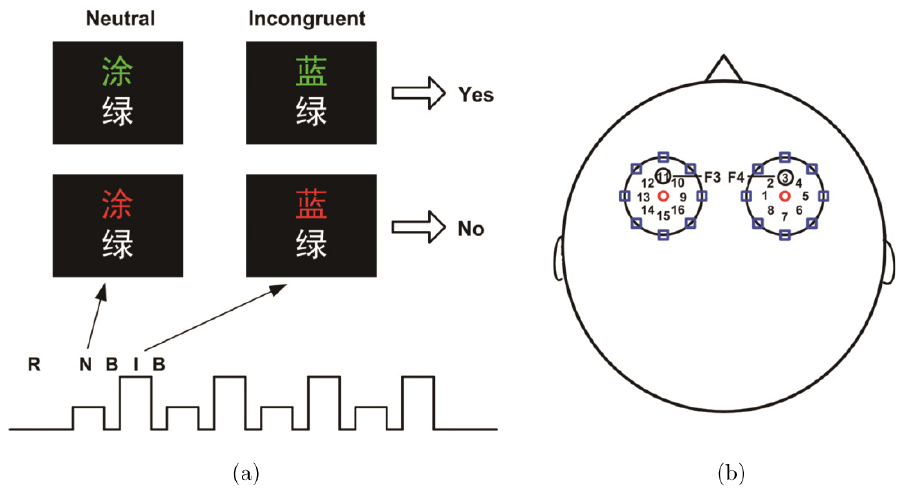
Fig. 1. (a) Examples of two stimulus conditions (top) and experimental design (bottom). , correspond to \blue", \green" and means \print". The bottom subgraph shows the blocks sequence in a run. R, 60 s rest period between runs; B, 15 s baseline between block; N, 30 s neutral block; I, 30 s incongruent block. (b) Position of the two NIRS probes on the head. The blue rectangle indicates the detector, and the red circle indicates the source. The number (1 – 16) at the midpoint of source – detector pair denotes the NIRS detector channel. Channel 3 was over F4 EEG electrode position and Channel 11 was over F3 EEG electrode